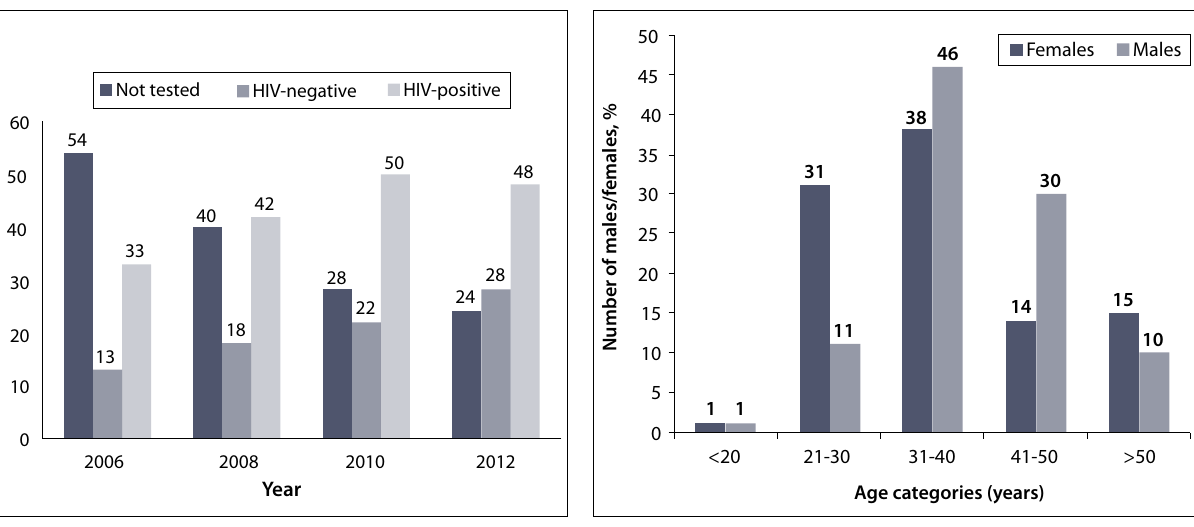
Fig. 2. Age categories of HIV-positive patients, suggesting that females died of neurological complications of HIV infection at a younger age than their male counterparts.